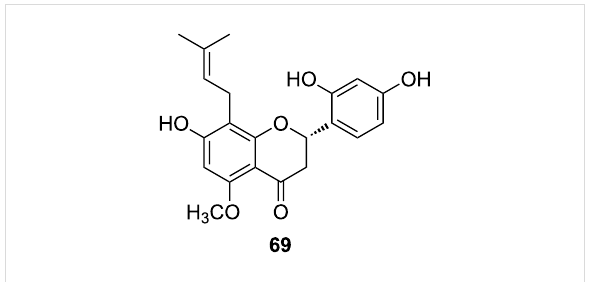
Figure 8: Structure of (2 S )-7,2’,4’-trihydroxy-5-methoxy-8-(dimethyl- allyl)flavanone ( 69